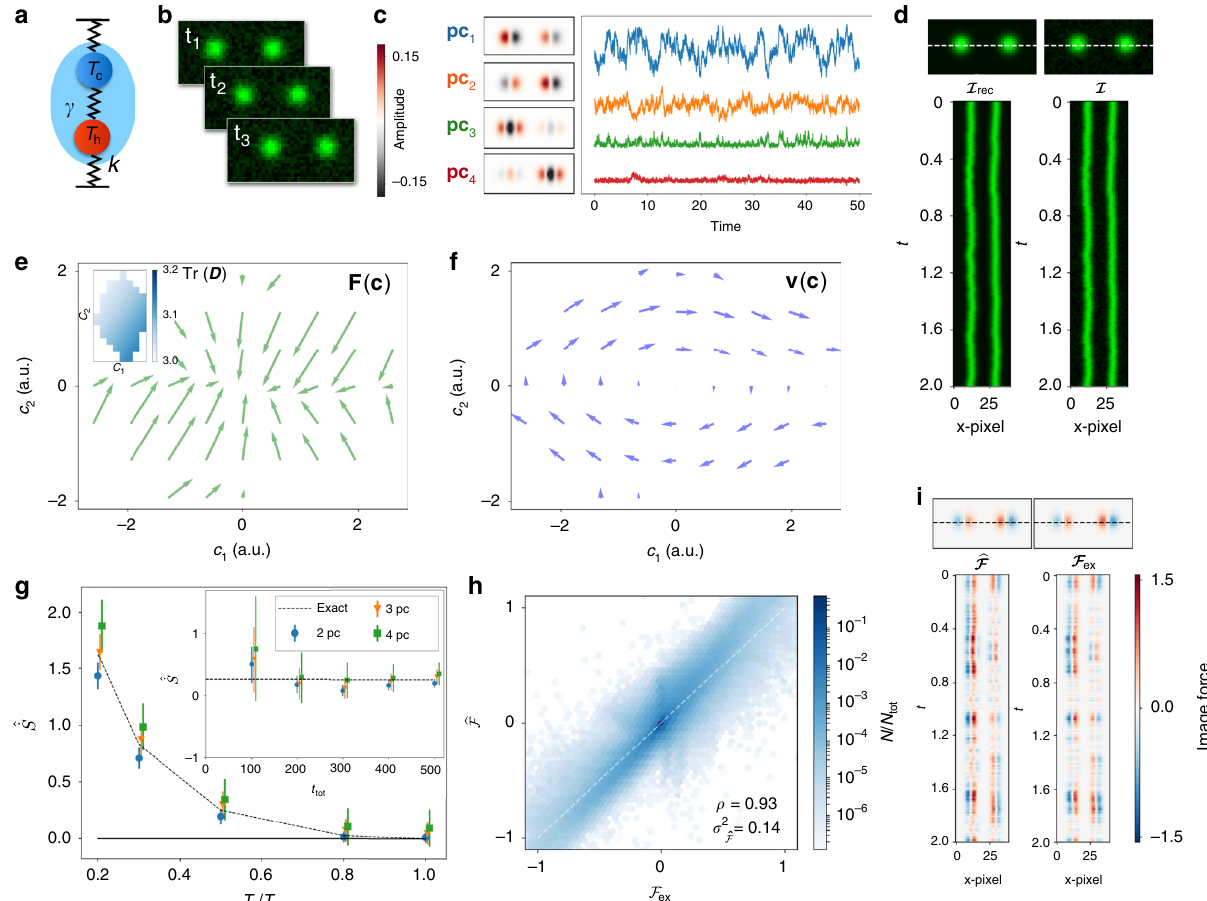
Fig. 2 Benchmarking the Brownian movie learning approach with a simple toy model. a Schematic of the two-bead model. The temperature of the hot bead T = 1 is fi xed and the temperature of the cold bead T ≤ 1 is varied. b 40×20 Frames of the noisy (10% noise) Brownian movie for the two-bead model at h c successive timepoints. c The fi rst four principal components (in arbitrary units) with time traces of respective projection coef fi cients. The color map displays negative values in black and positive values in red. d Snapshot I rec of the reconstructed movie, reconstructed with the fi rst four principal components, and snapshot I of the original movie (right), together with associated kymographs. Pixel intensity ranges from 0 (black) to 1 (bright green). We compare pixel intensities along the superimposed horizontal dashed line. Force fi eld ( e ) and mean phase-space velocity ( f ) in the space of the fi rst two principal components b _ S { c 1 , c 2 }. Arrows are scaled for visualization purposes. Inset e : trace of diffusion tensor Tr ð D Þ with the same axis scaling. g Inferred entropy production rate for b _ S ¼ 0 : 5. The error bars varying temperature ratio T c T (cid:2) 1 and number of included principal components. Inset: as a function of trajectory length for a fi xed T c T (cid:2) 1 h h represent an estimate of the root-mean-square deviation between the true apparent entropy production rate and the inferred value (see Methods). h Scatter plot of the elements of the exact image-force fi eld F ex vs. the inferred image-force fi eld b F for different pixels and timepoints (data have been binned for visualization purposes). Results are obtained using the fi rst four principal components. i Comparison of inferred b F and exact b F image-space force fi elds, ex together with associated